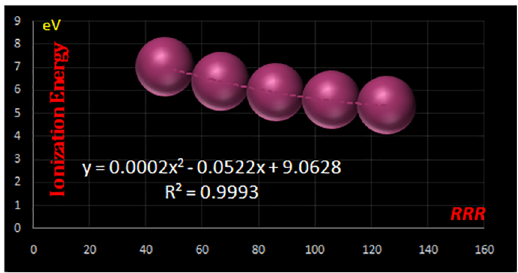
Figure 4. Shows Ionization Energy changes in Circumacenes family according to RRR index.